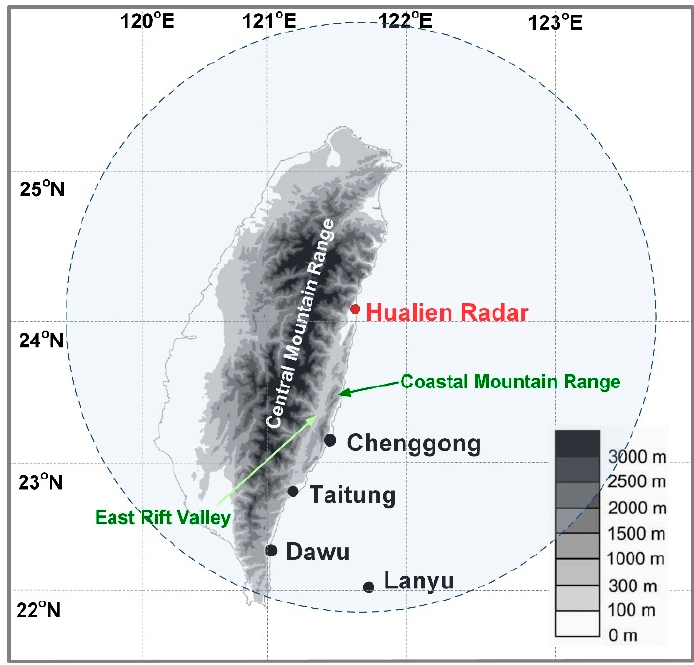
Figure 1. Locations of the Hualien WSR and experimental stations. Table 1. Typhoon events affecting the study area.